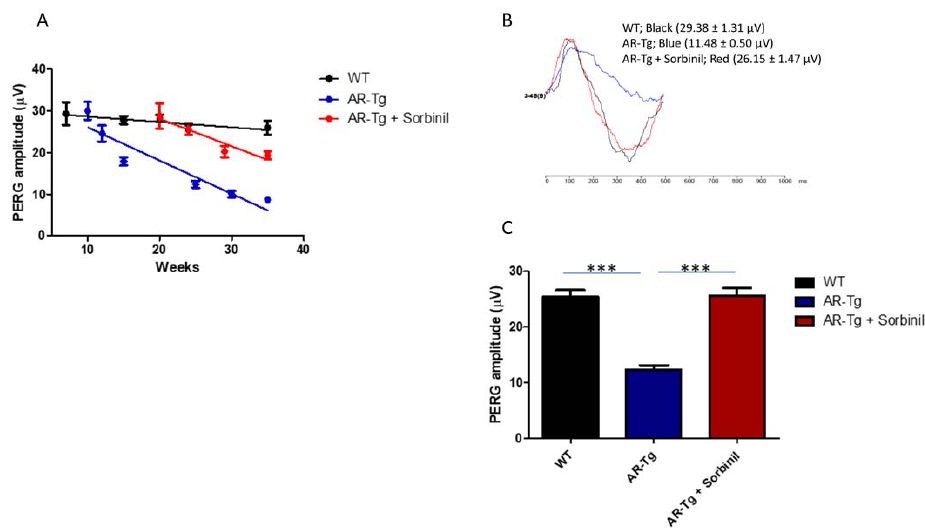
Figure 5. AR-Tg mice experienced an age-dependent loss of ganglion cell function that could be moderated by the inhibition of AR activity. Ganglion cell activity was determined by PERG in AR-Tg and nontransgenic control mice. ( A ) Serial PERG amplitude recordings were performed on the same animal from age 7 to 35 weeks. Nontransgenic control (WT); black line, AR-Tg; blue line, AR-Tg treated with Sorbinil; red line, error bars represent the SD ( n = 5). ( B ) Average PERG amplitudes at age 24 weeks indicated a >60% reduction in PERG of AR-Tg animals compared to age-matched WT controls. ( C ) Treatment of AR-Tg animals with Sorbinil; however, returned PERG amplitude to near normal levels (*** p < 0.001). Data shown as the mean ± SEM, n ≥ 5 for each group, at 24 weeks. *** p < 0.001.